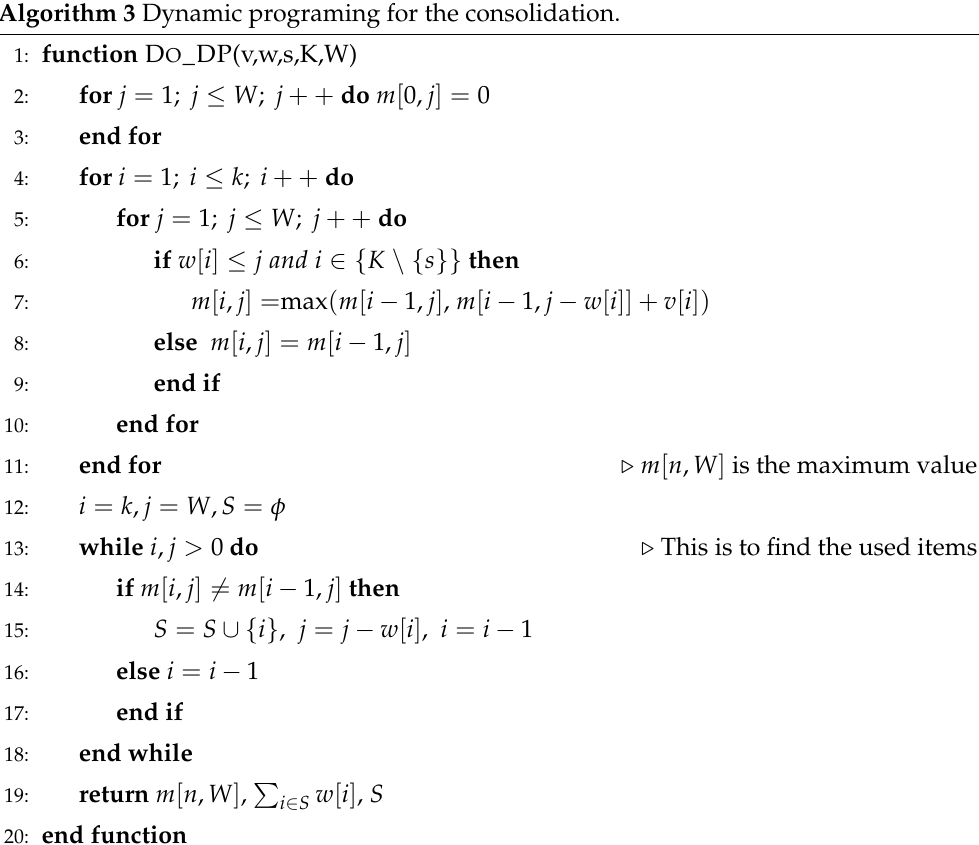
Algorithm 3 Dynamic programing for the